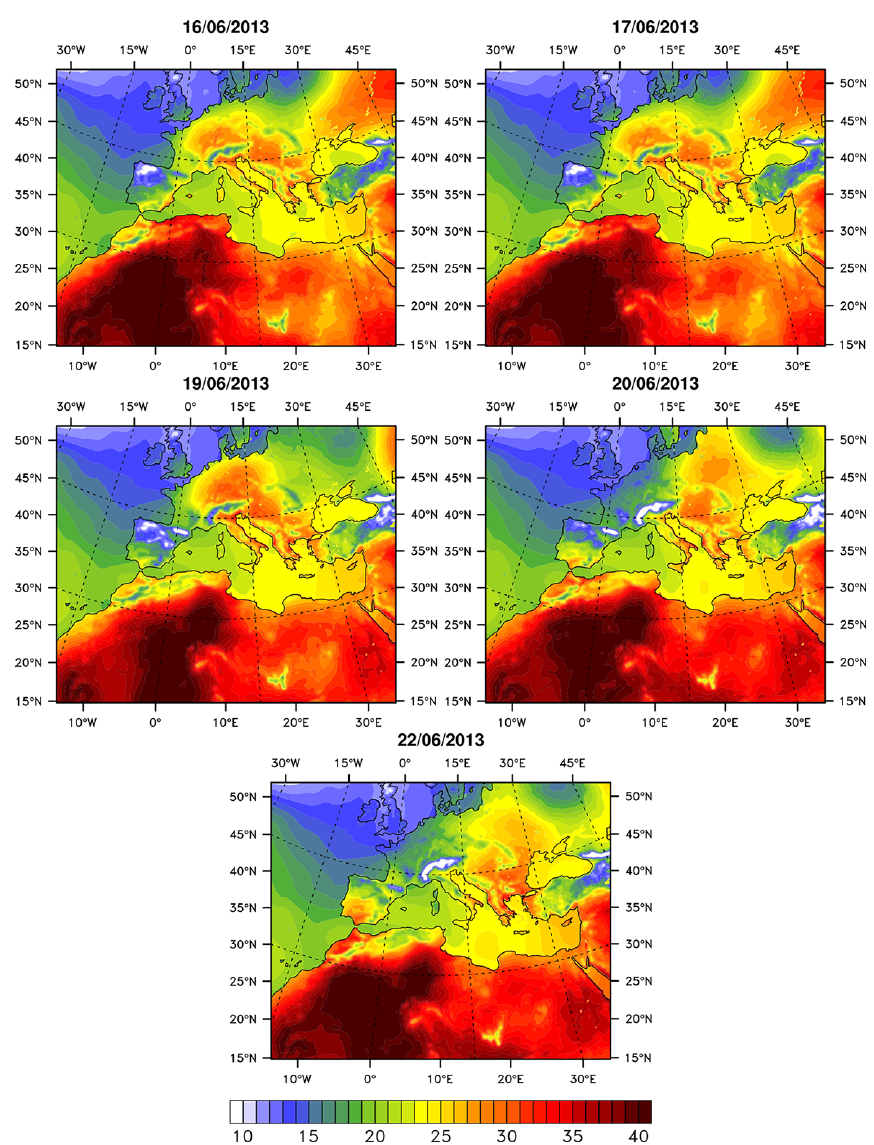
Figure 9. Surface temperature (at 12:00UTC) obtained from NCEP re-analysis for 16, 17, 19, 20 and 22